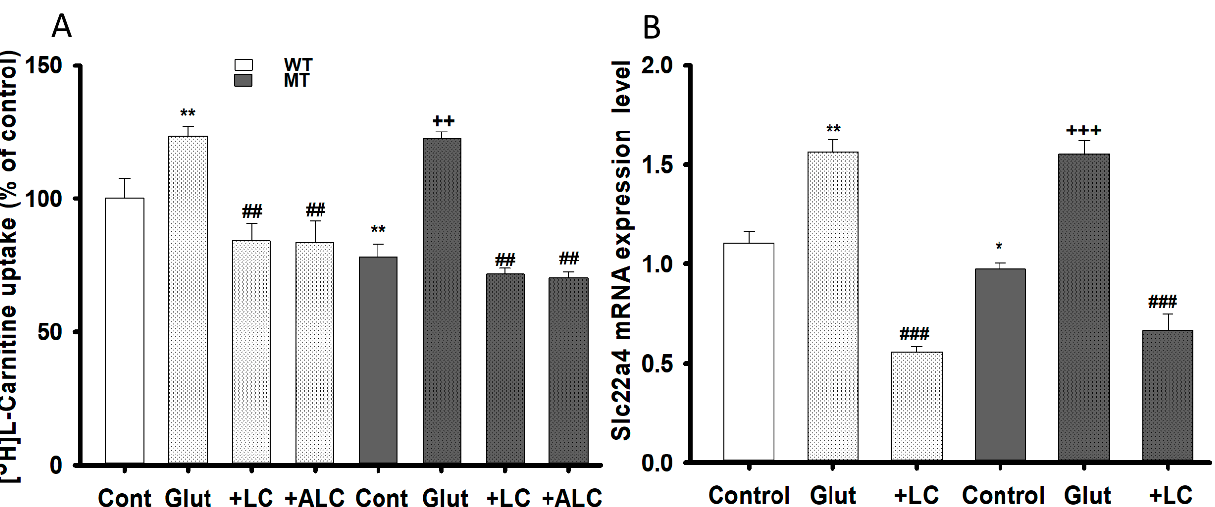
Figure 8. LC and ALC restoration effect following glutamate excito-toxicity on carnitine transport system. NSC-34 WT and MT cell lines were pretreated with Glutamate, LC and ALC (1 mM) for 24 h and [ 3 H]L-carnitine uptake ( A ) and OCTN1/slc22a4 mRNA expression ( B ) were evaluated. Each value represents the mean ± S.E.M ( n = 4); ** p < 0.01; * p < 0.05 were significantly different from the WT control, ### p < 0.001 and ## p < 0.01, significantly different from glutamate and +++ p < 0.001 and ++ p < 0.01, significantly different from MT control.